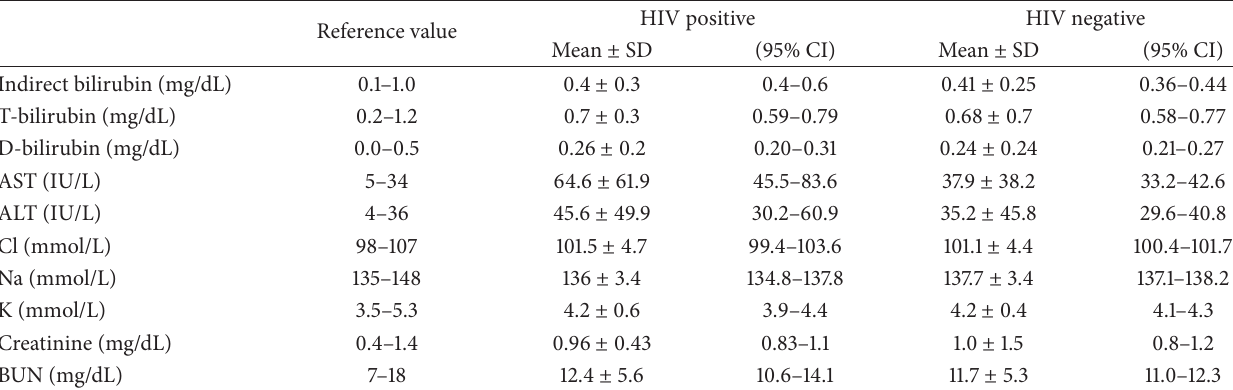
Table 4: Biochemistry parameters among TB and TB-HIV